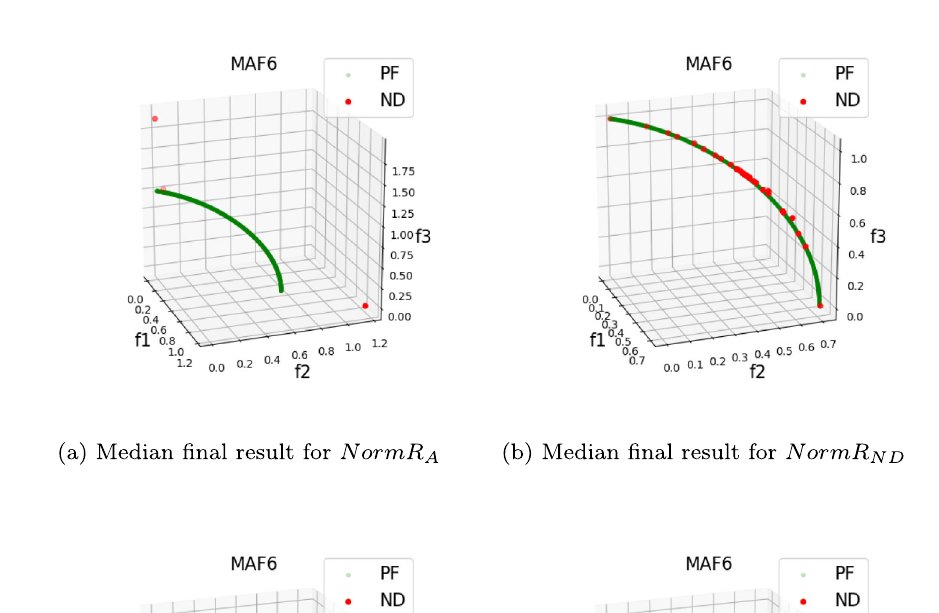
Fig. 8 Typical scenario observed for 3-objective MAF6